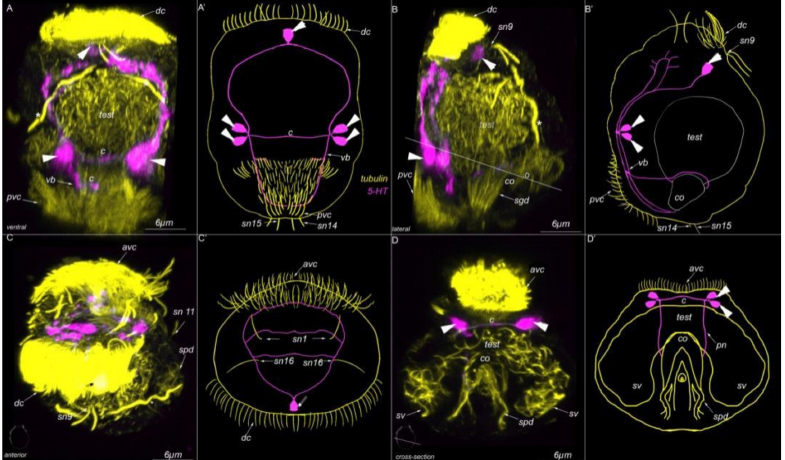
Figure 9. Tubulin-like immunoreactivity in the mature dwarf male of Dimoprhilus gyrociliatus . ( A , A (cid:48) ) Anterior view on wholemount and schematic representation. ( B , B (cid:48) ) A cross-section at the middle part of the body and its schematic representation. ( C , C (cid:48) ) A cross section of the posterior body region and its schematic representation. ( D , D (cid:48) ) A cross section of the posterior body region at the level of stylet gland cells and its schematic representation. Abbreviations: arrowheads indicate neuronal cell bodies; avc —anterior ventral cilia; dc —dorsal commissure; vc —ventral commissure; c — commissure; co —copulatory organ; go —genital opening; test —testis; pvc —posterior cilia; sgd —stylet gland cell; sn1–sn20 —sensory neurons1–20; sv —seminal vesicles; vb —ventral bundle; *—nephridia.